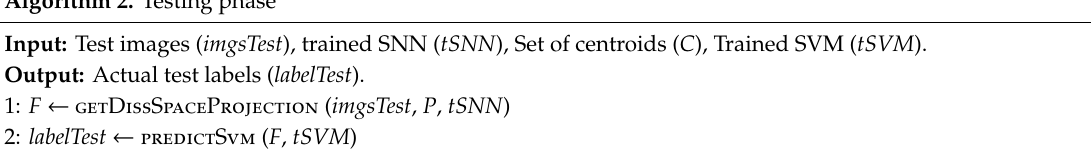
Algorithm 2. Testing